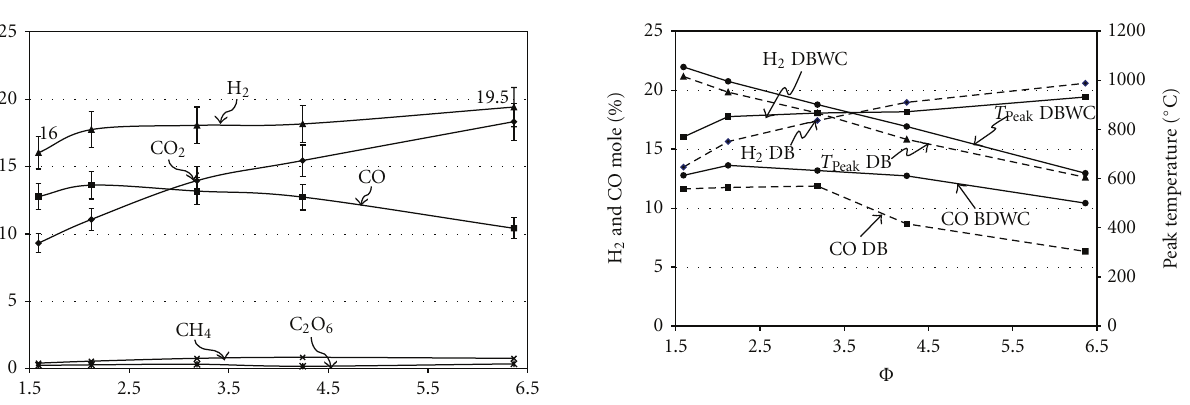
Figure 6: Comparison between H 2 and CO produced by gasifica- tion of DBWC and DB at S : F = 0 . 4, curves of DB adapted from